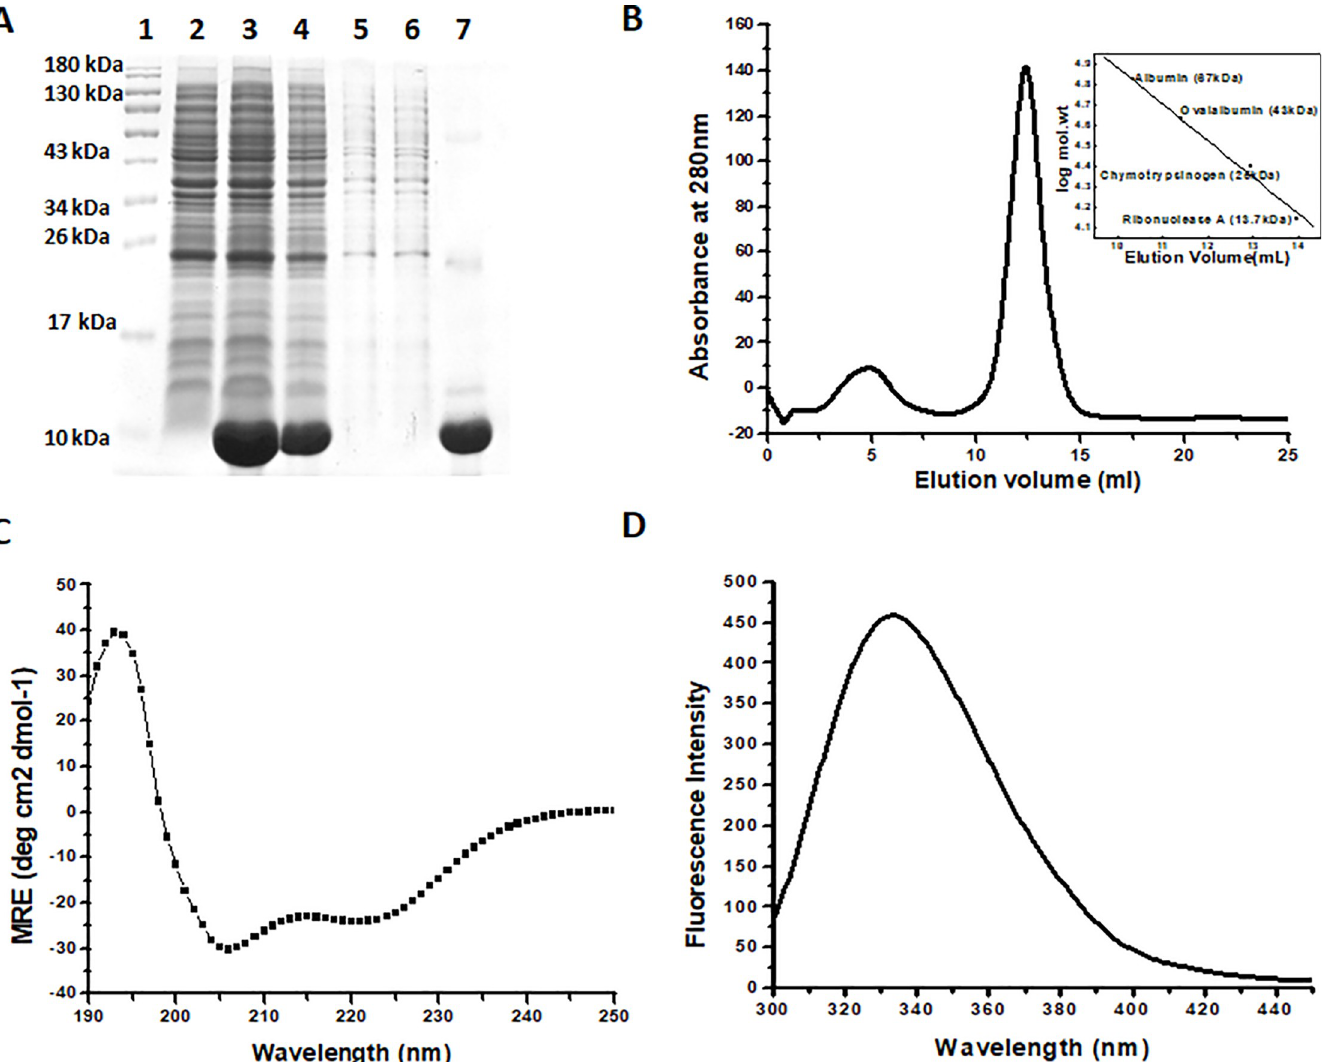
Fig 2. Purification and structural characterization of Sus1. (A) Denaturing gel representing the protein sample at different stages of the purification. Lane 1 represents the protein marker while 2,3,4,5,6,7 represent the uninduced cell lysate, induced cell lysate, soluble fraction of the cell lysate, washing fraction 1 (washing with equilibration buffer with 20 mM imidazole), washing fraction 2 (washing with equilibration buffer with 50 mM imidazole) and elution fraction (elution with equilibration buffer with 300 mM imidazole) respectively. (B) AKTA profile of purification of the Sus1 elution fraction 3 using SuperdexTM 75, 10/300GL column. Inset represents the standard plot between the log mol. weight and elution volume. The proteins taken to plot standard graph are 67KDa (Albumin), 43KDa (Ovaalbumin), 25KDa (Chymotrypsinogen) and 13.70KDa (Ribonuclease A). (C) CD spectra of the native protein represent two minima at 208 nm and 222 nm. (D) Fluorescence spectra of native